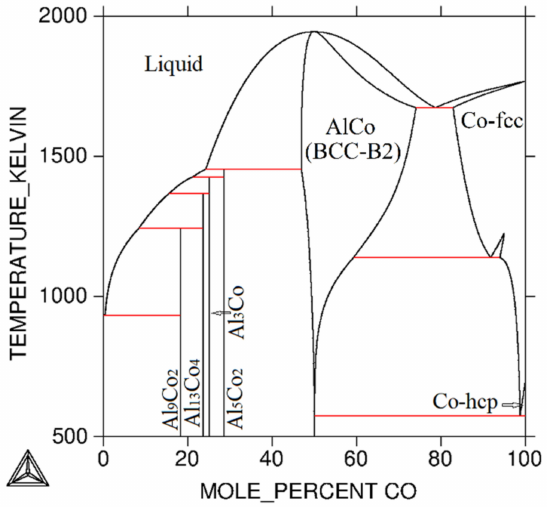
Figure 1. Phase diagram of the Al–Co binary system, data for calculation were taken from [16].